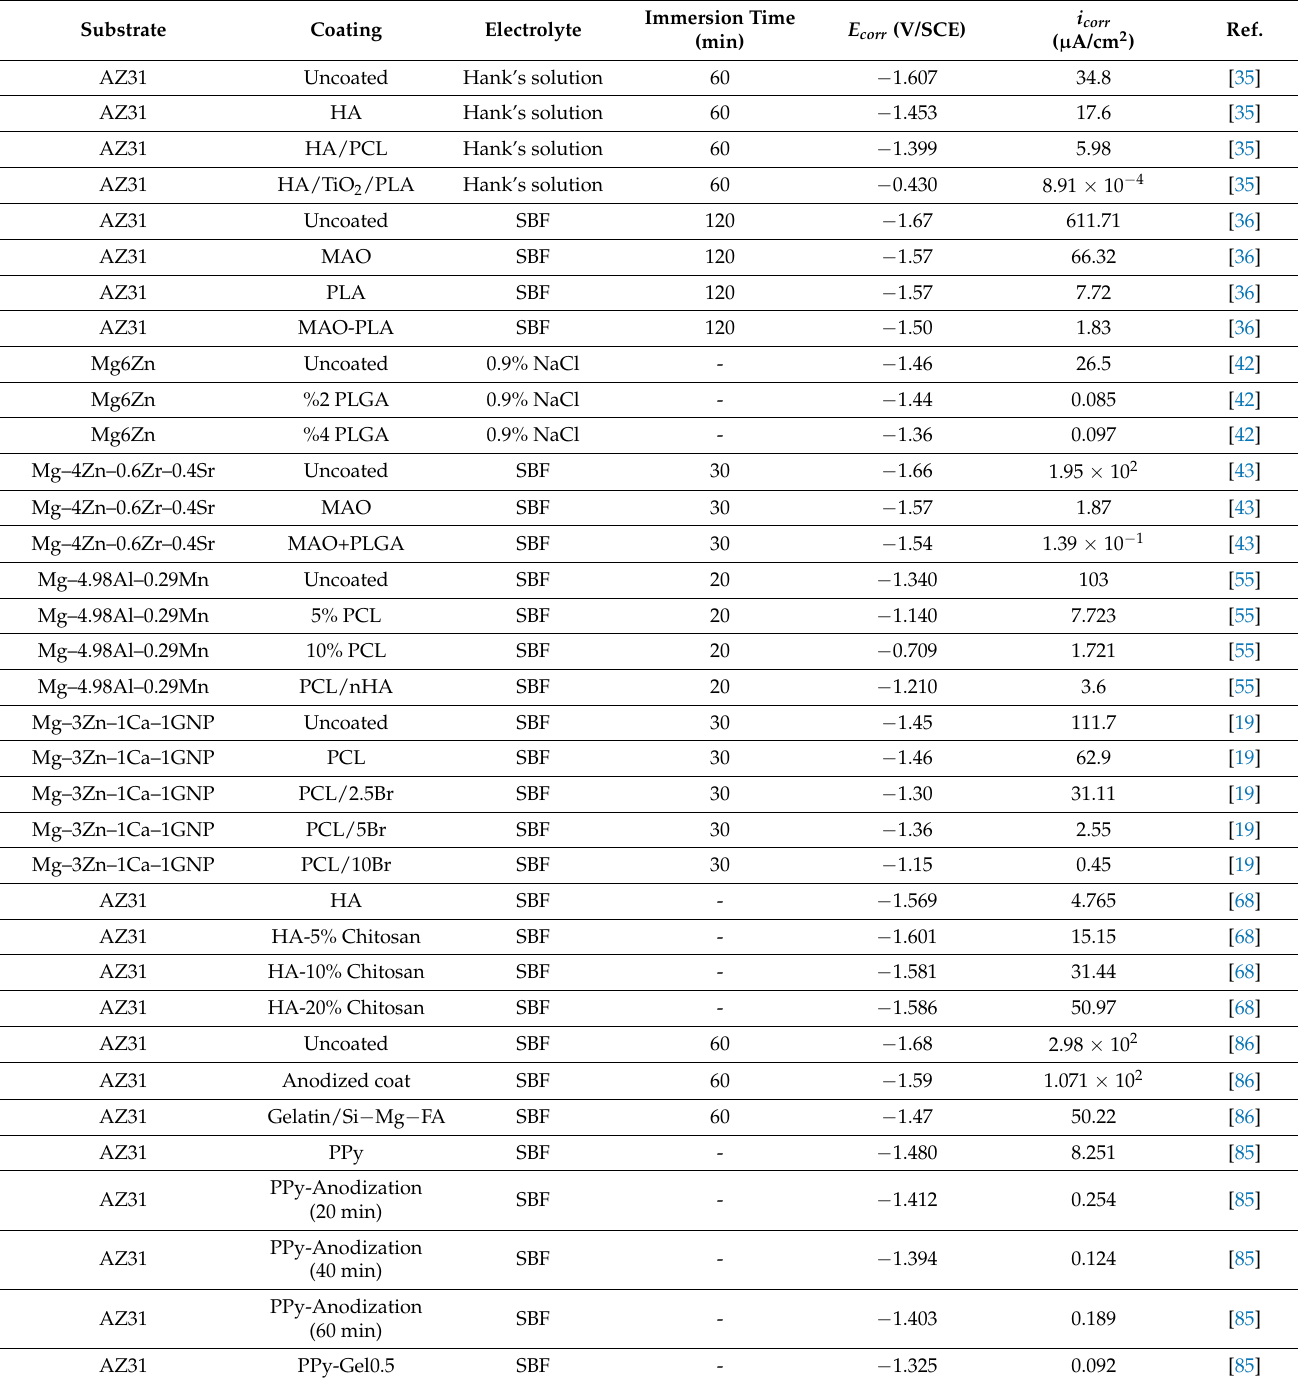
Table 3. Corrosion properties of polymer-coated and composite-coated Mg-based composites and Mg